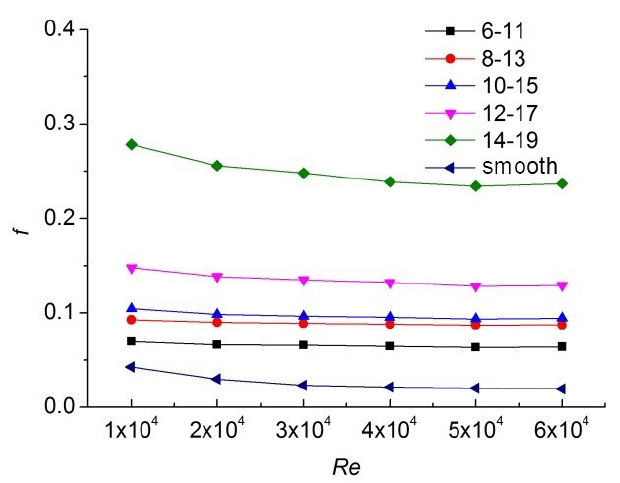
Figure 8. The variation of resistance coefficient f in tube with Re.